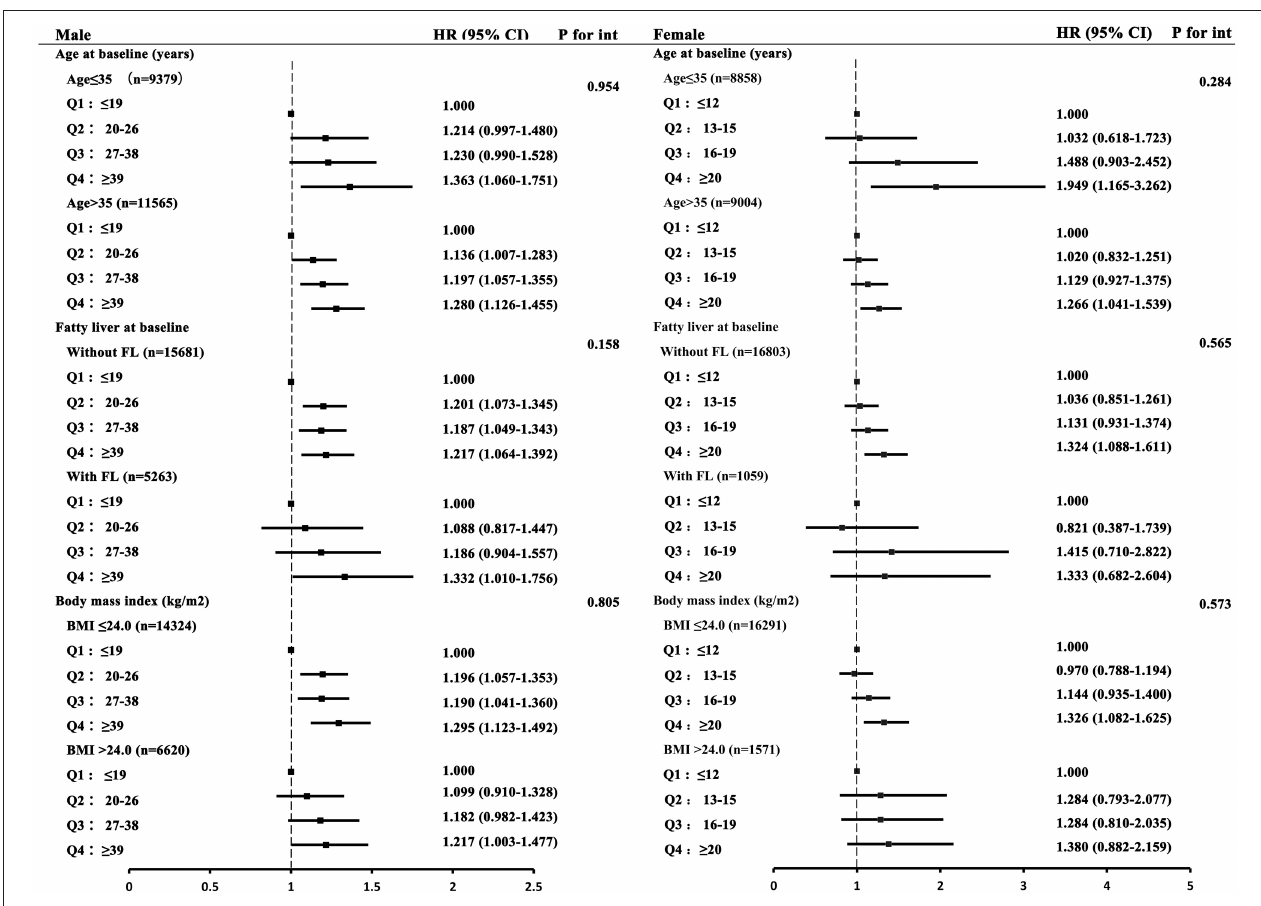
FIGURE 3 | Forest plots of hazard ratios (HRs) with 95% confidence intervals (CIs) for quartiles of serum gamma-glutamyltransferase (GGT) levels stratified by sex. The values were adjusted for sex, age, body mass index (BMI), baseline systolic blood pressure, baseline diastolic blood pressure, fasting plasma glucose, total cholesterol, triglyceride, high-density lipoprotein cholesterol, low-density lipoprotein cholesterol, creatinine, alanine aminotransferase, aspartate aminotransferase, creatinine, and fatty liver (FL) status. P for int: P -values for the effect modification of age, FL status, and BMI on the association between serum GGT level and incidence of